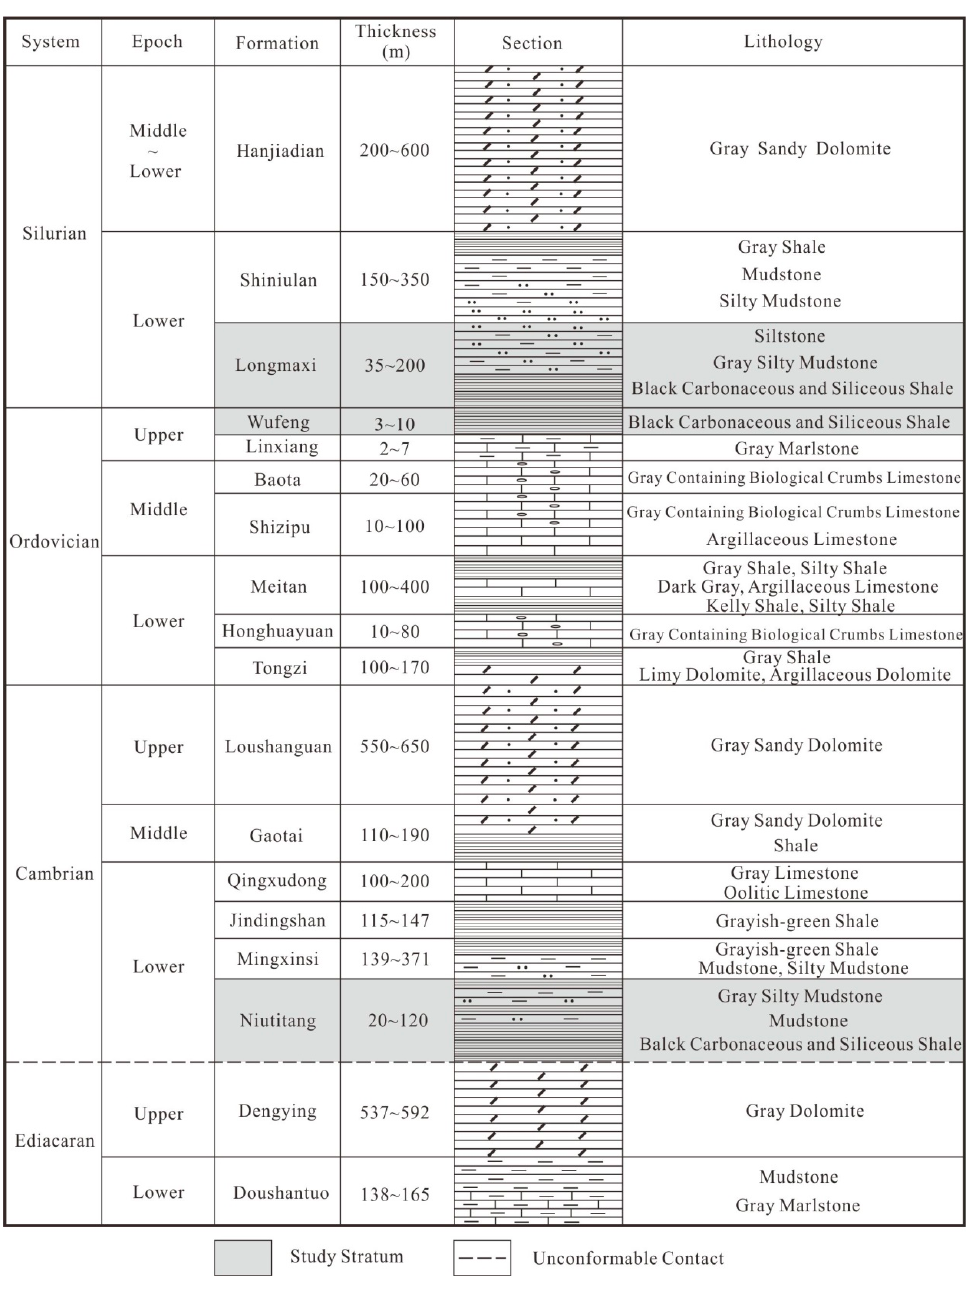
Figure 2. Integrated stratigraphic column of the southeastern margin of the Sichuan Basin.